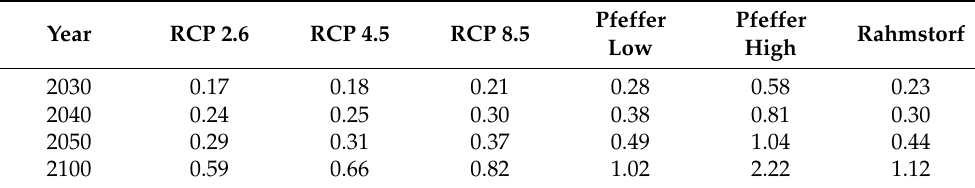
Table 4. Total Sea-Level Rise (m) (TSLR P ) at Victoria Beach, projecting the years 2030, 2040, 2050, and 2100, according to the different models and scenarios.